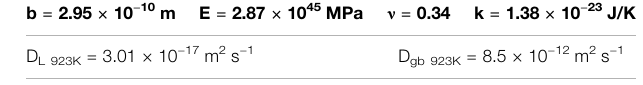
TABLE 1 | Physical parameters of Ti-6Al-4V alloys (Reca and Libanati, 1968; Stowell et al., 1984).